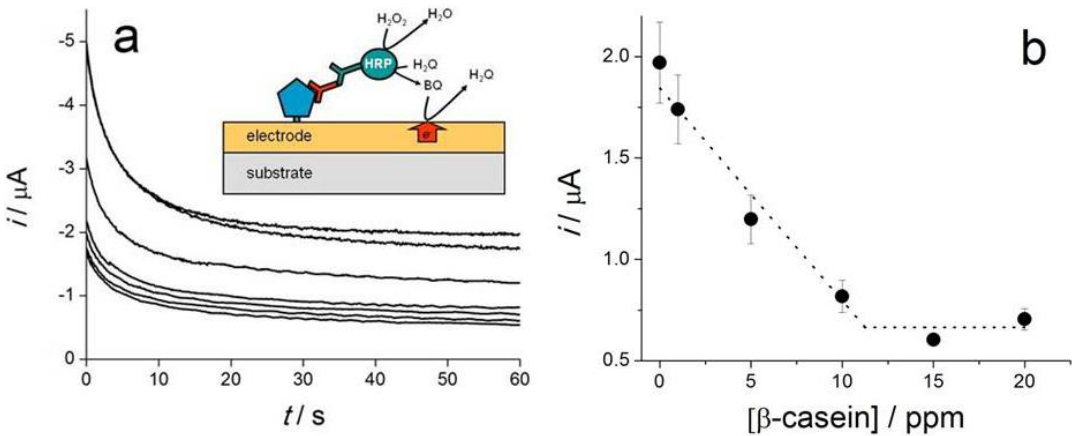
Figure 6. Chronoamperometric detection of benzoquinone formed as result of casein binding in the immunosensor for several casein concentrations ( a ) and calibration curve obtained based on the intensity of the current recorded after 60 s from applying the potential ( b ). Reproduced from [35] by the terms and conditions of the Creative Commons Attribution license (http://creativecommons.org/ licenses/by/4.0/).